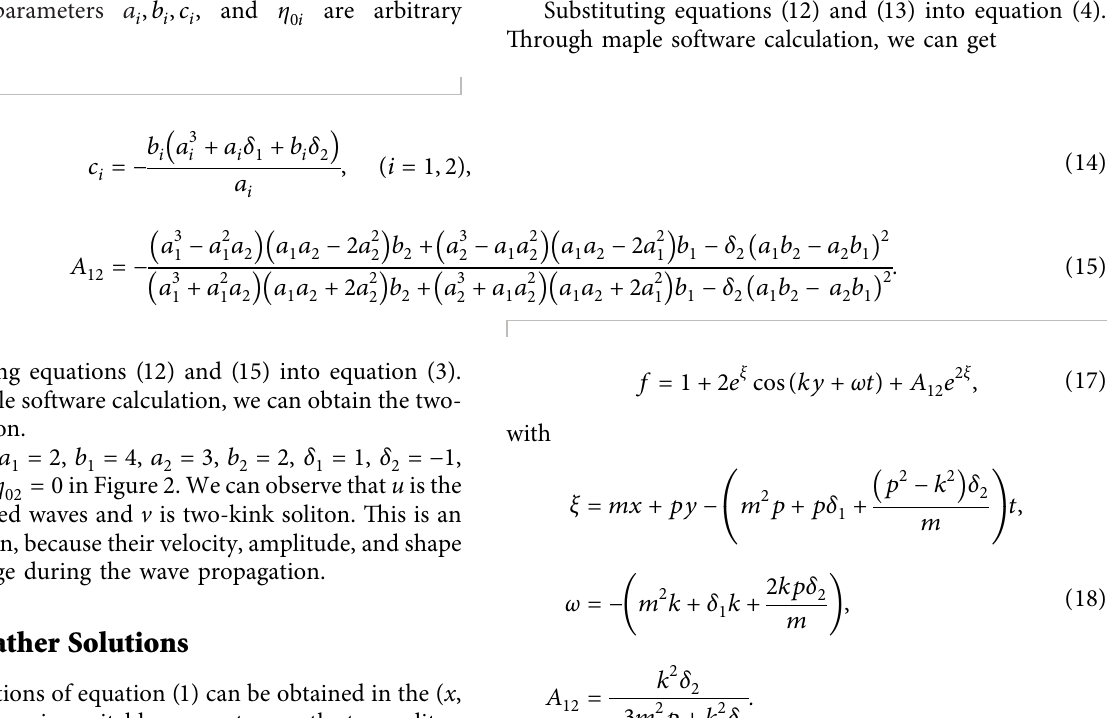
� 2 , b � 4 , δ � 1 , δ � − 1 , and η � 0,at t � 0.(a) u .(b) v 1 1 1 2 01